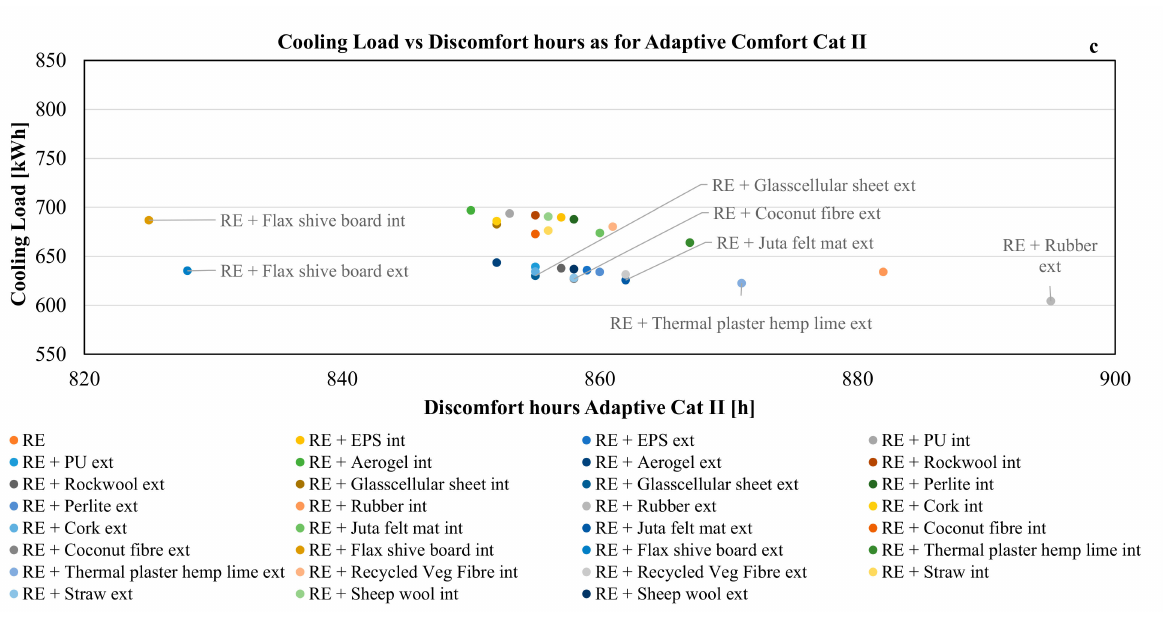
Figure 7. Cooling loads vs. total building cost ( a ), embodied carbon ( b ), and discomfort hours as for category II of adaptive comfort model ( c ). Optimised rammed earth (RE) insulated wall constructions indicated with labels.